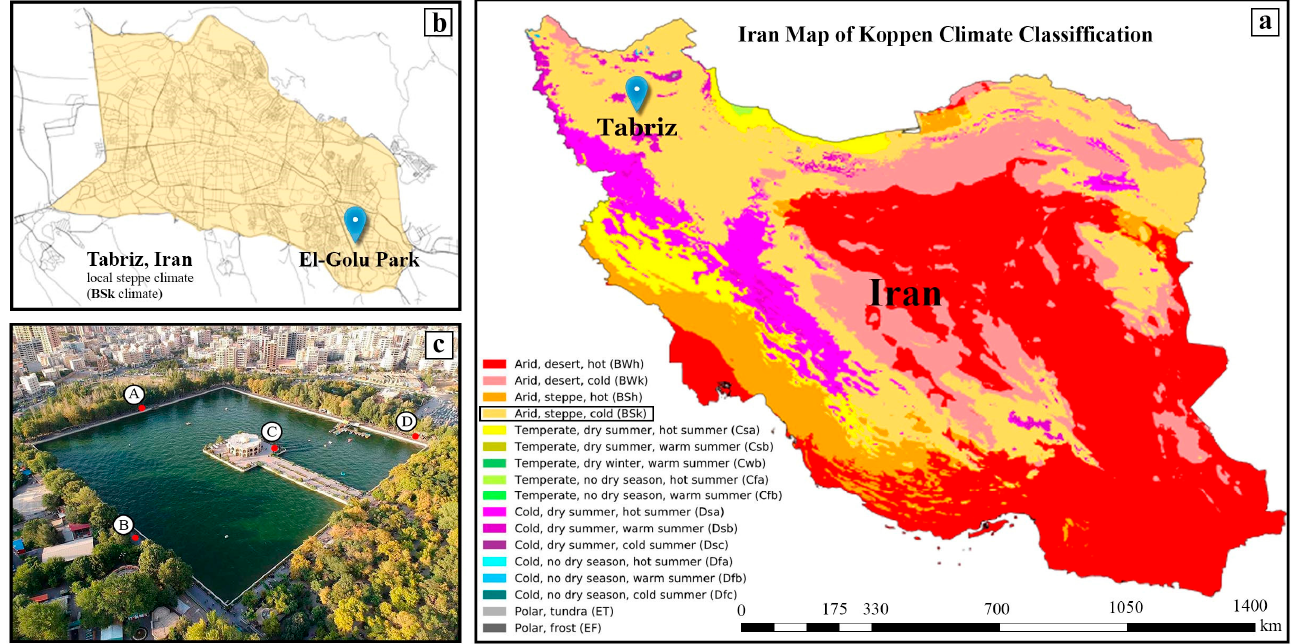
Figure 1. Iran map of Koppen climate classification ( a ) [50], location of the studied site in Tabriz map ( b ) [51], measurement points on the site of El-Golu park ( c ). The highest percentage of district surfaces are covered in, respectively: trees (36%); water body (27%); granite pavement (sidewalk, 21%); asphalt surface (13%); and buildings (3%).